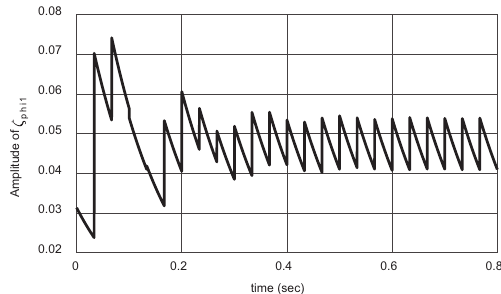
ξ amplitude in ideal ON-OFF 1 φ